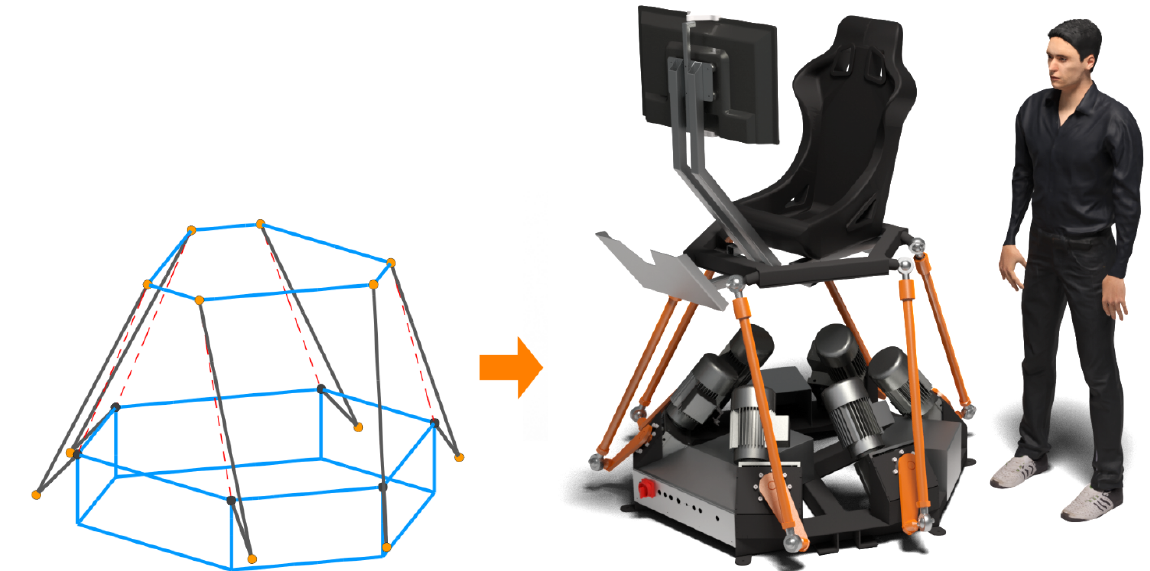
Figure 19. Materialization of the mechanism.